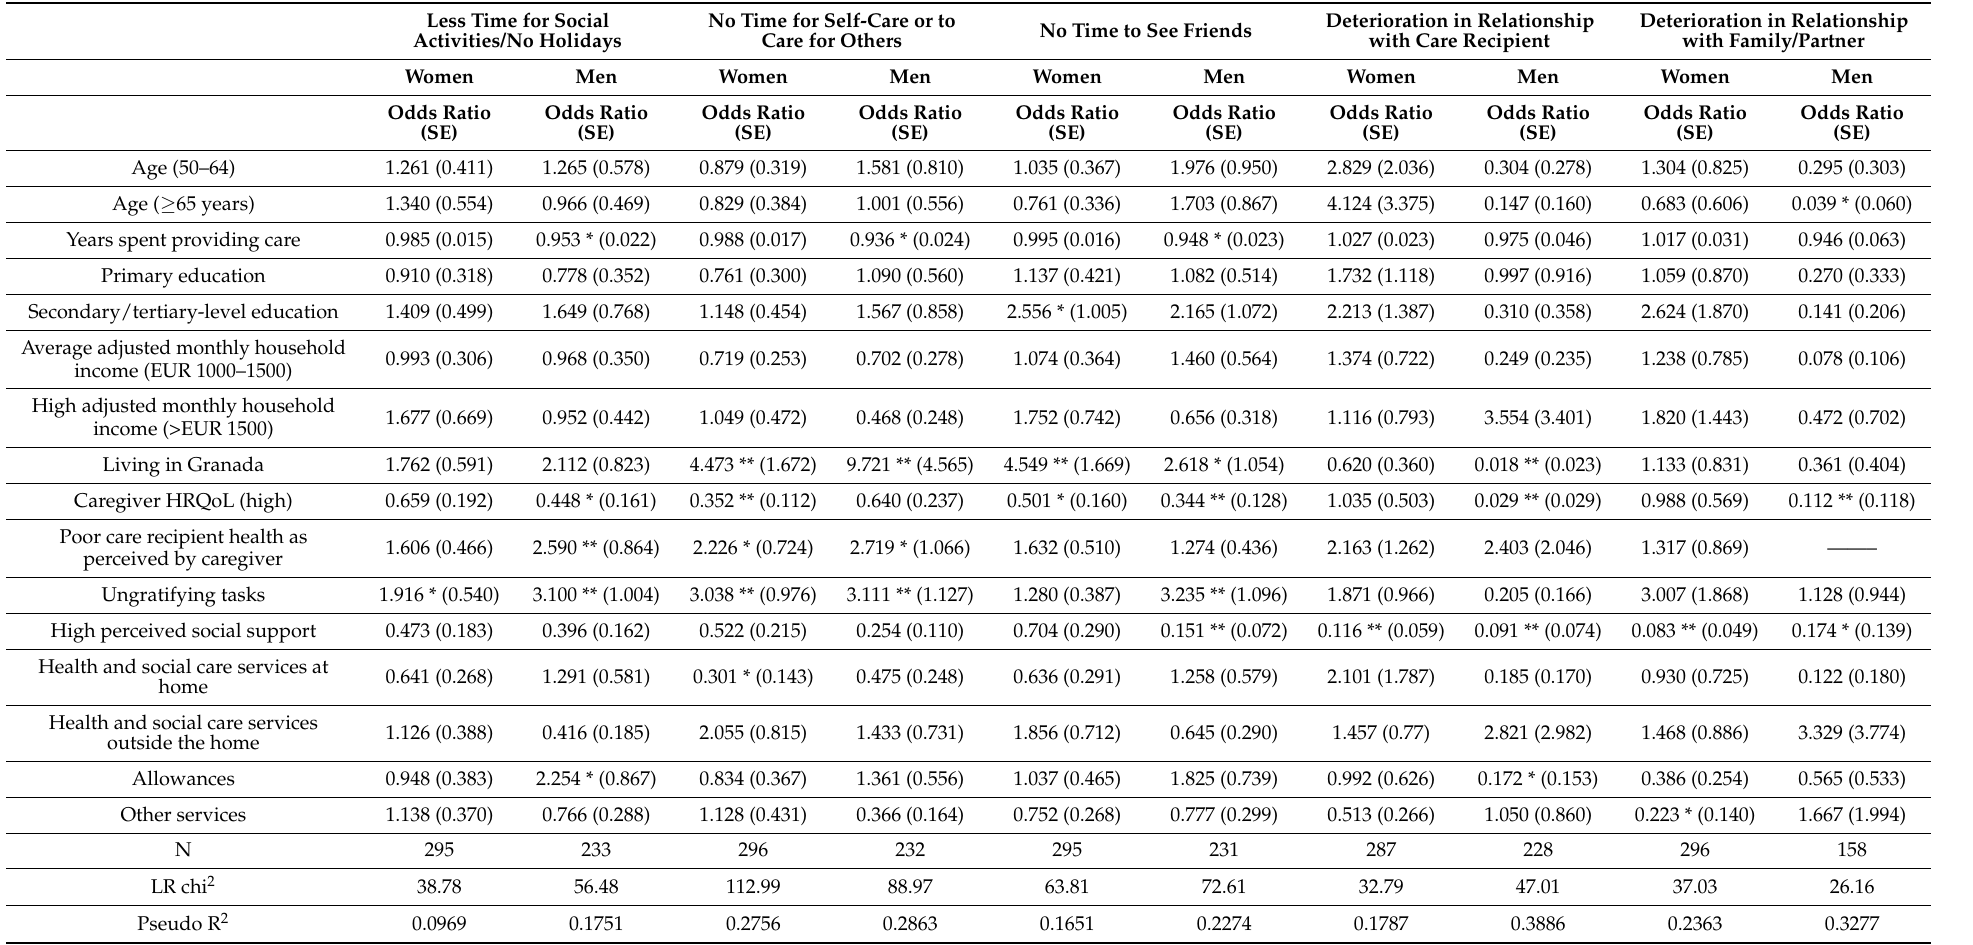
Table 6. Analysis of problems with social and family relationships perceived by male and female